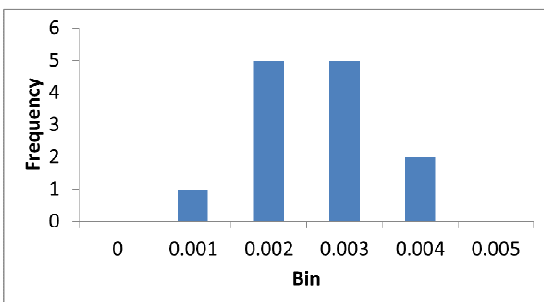
Figure 7. Histogram of one-sigma standard deviation values for 14 randomly selected least-squares plane fittings on horizontal ground surfaces within the ILRIS-LR point cloud.